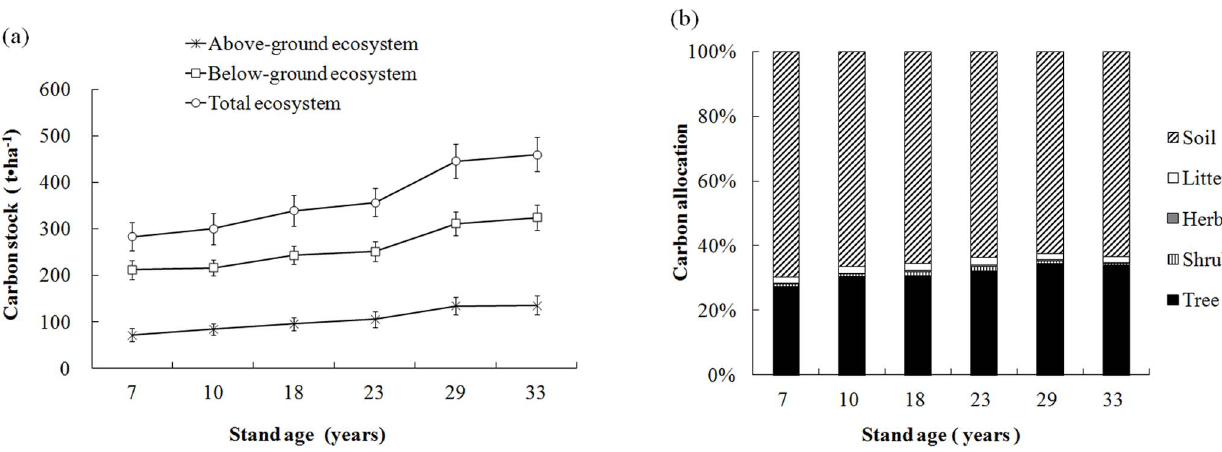
Figure 4. Carbon stocks in ecosystem components (a) and their proportional allocation (b) in six differently aged Mytilarialaosensis stands. Values in (a) are means 6 SE,